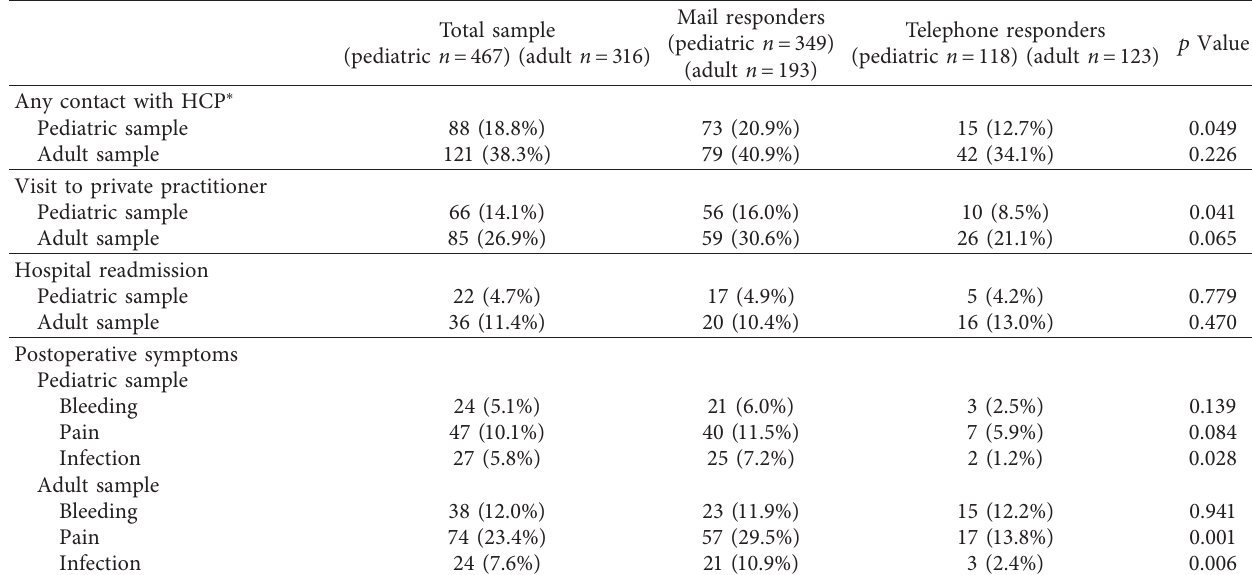
Table 2: Comparison of postoperative complication rates and symptoms for mail and telephone responders by age